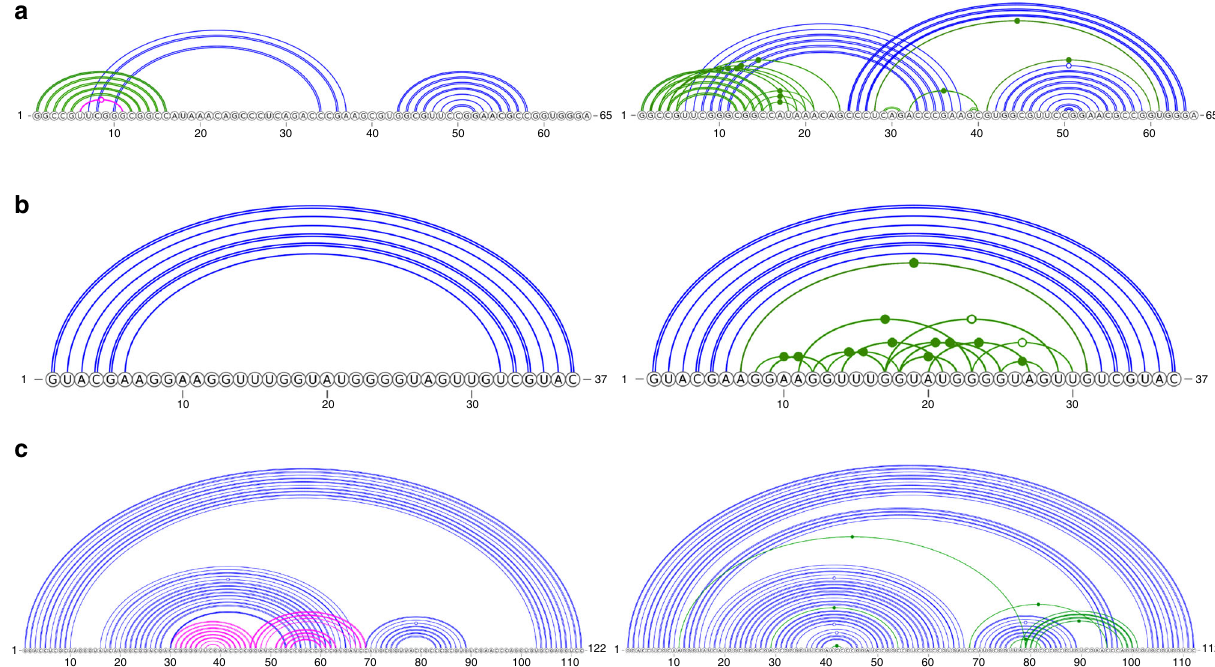
Fig. 5 Comparison of SPOT-RNA prediction with the native structure of a Pistol Ribozyme, Mango aptamer, and Adenovirus Virus-associated RNA. The secondary structure of a Pistol Ribozyme (chain A and B in PDB ID 6r47), the Mango Aptamer (chain B in PDB ID 6e8u), and the adenovirus virus- associated RNA (chain C in PDB ID 6ol3) represented by arc diagrams with canonical base pair (BP) in blue color, noncanonical, pseduoknot BP and lone pair in green color, and wrongly predicted BP in magenta color: a predicted structure by SPOT-RNA (on left), with 93 % precision and 41 % sensitivity, as compared with the native structure (on right) for the Pistol Ribozyme, b the predicted structure by SPOT-RNA (on left) with 100 % precision and 26 % sensitivity, as compared with the native structure (on right) for the Mango aptamer, c the predicted structure by SPOT-RNA (on left) with 66 % precision and 60 % sensitivity, as compared with the native structure (on right) for the adenovirus virus-associated